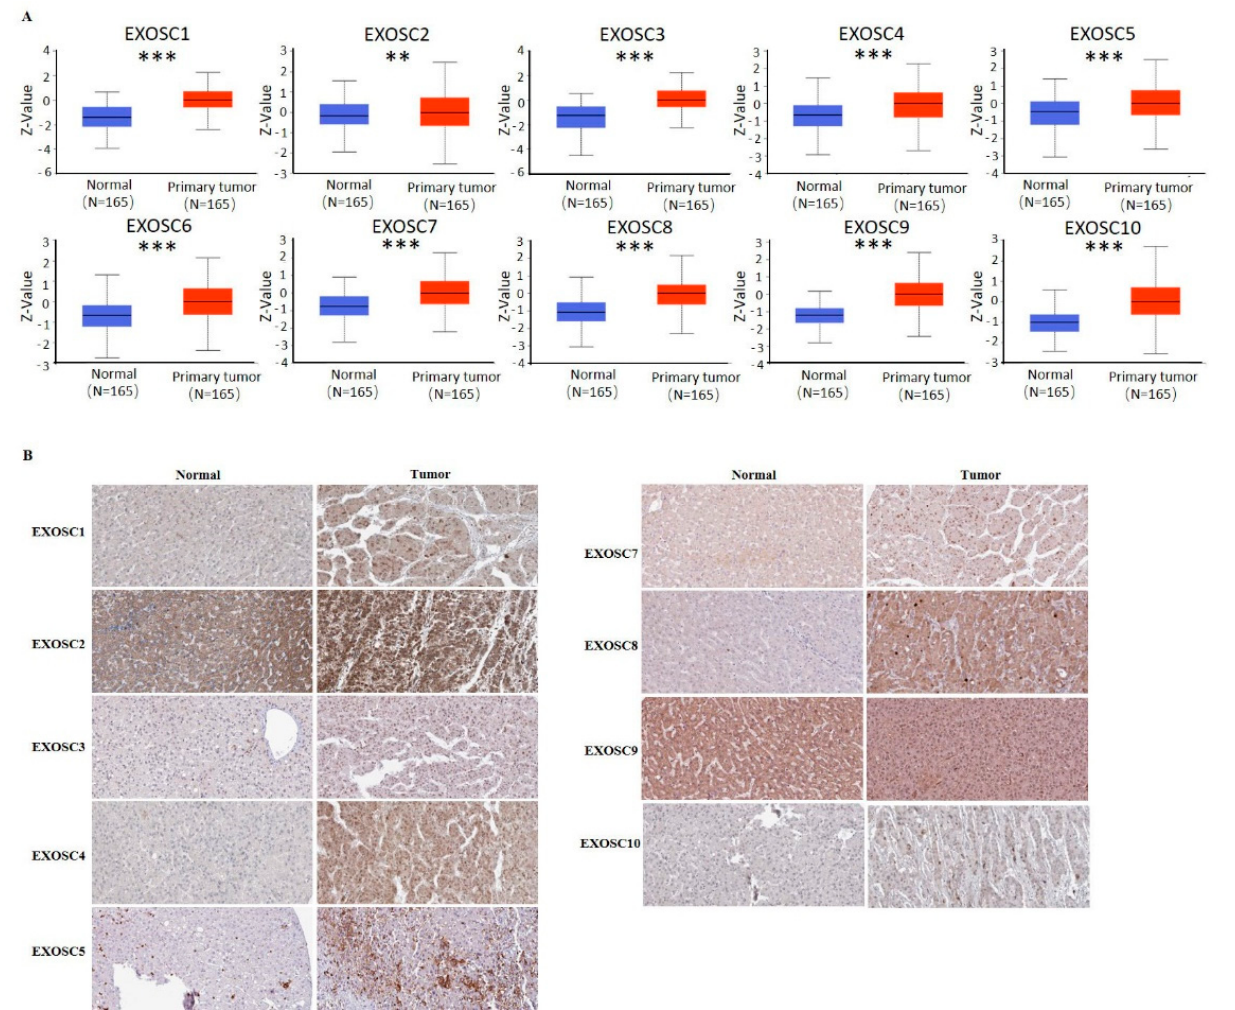
Figure 2. The protein levels of EXOSCs in HCC tumor and normal tissues. EXOSCs in HCC tissues were compared with that in normal tissues by ( A ) Ualcan and ( B ) Human Protein Atlas database. ** p < 0.01, *** p < 0.001.